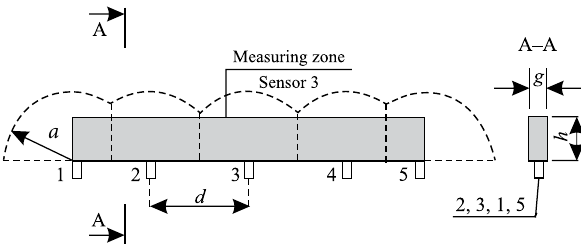
Fig. 4. Measuring zones covering the entire element: d – distance between sensors, cm; g – element thickness, cm; h – height of the element, cm; a – radius of a sensor measuring surface, cm